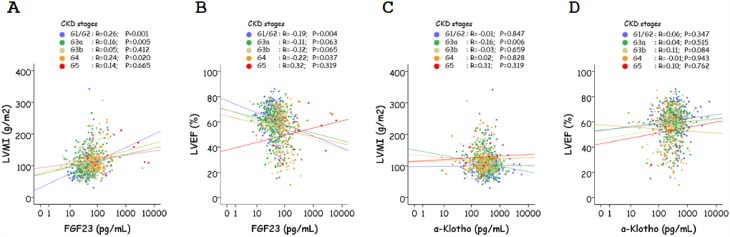
Correlation between FGF23, α-Klotho, left ventricular mass index (LVMI), and left ventricular ejection fraction (LVEF) according to CKD stages.A. Correlation between FGF23 and LVMI. B. Correlation between FGF23 and LVEF. C. Correlation between α-Klotho and LVMI. D. Correlation between α-Klotho and LVEF. The results of Spearman’s correlation test for each CKD stage subgroup are shown.